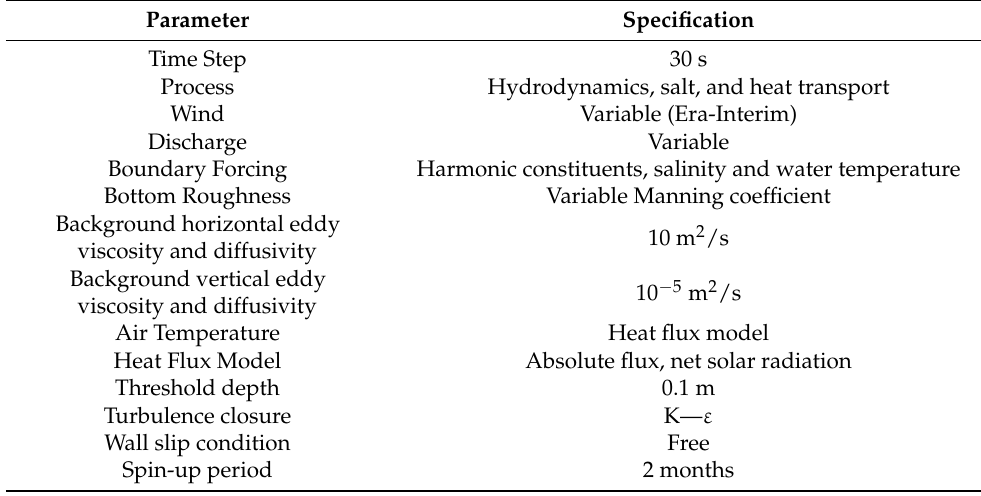
Table 1. Parameters and specifications of model